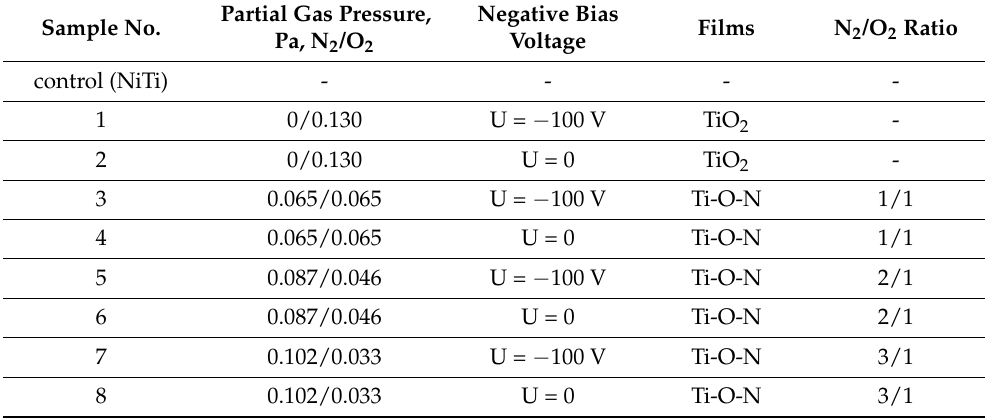
Table 5. Details of the deposition modes